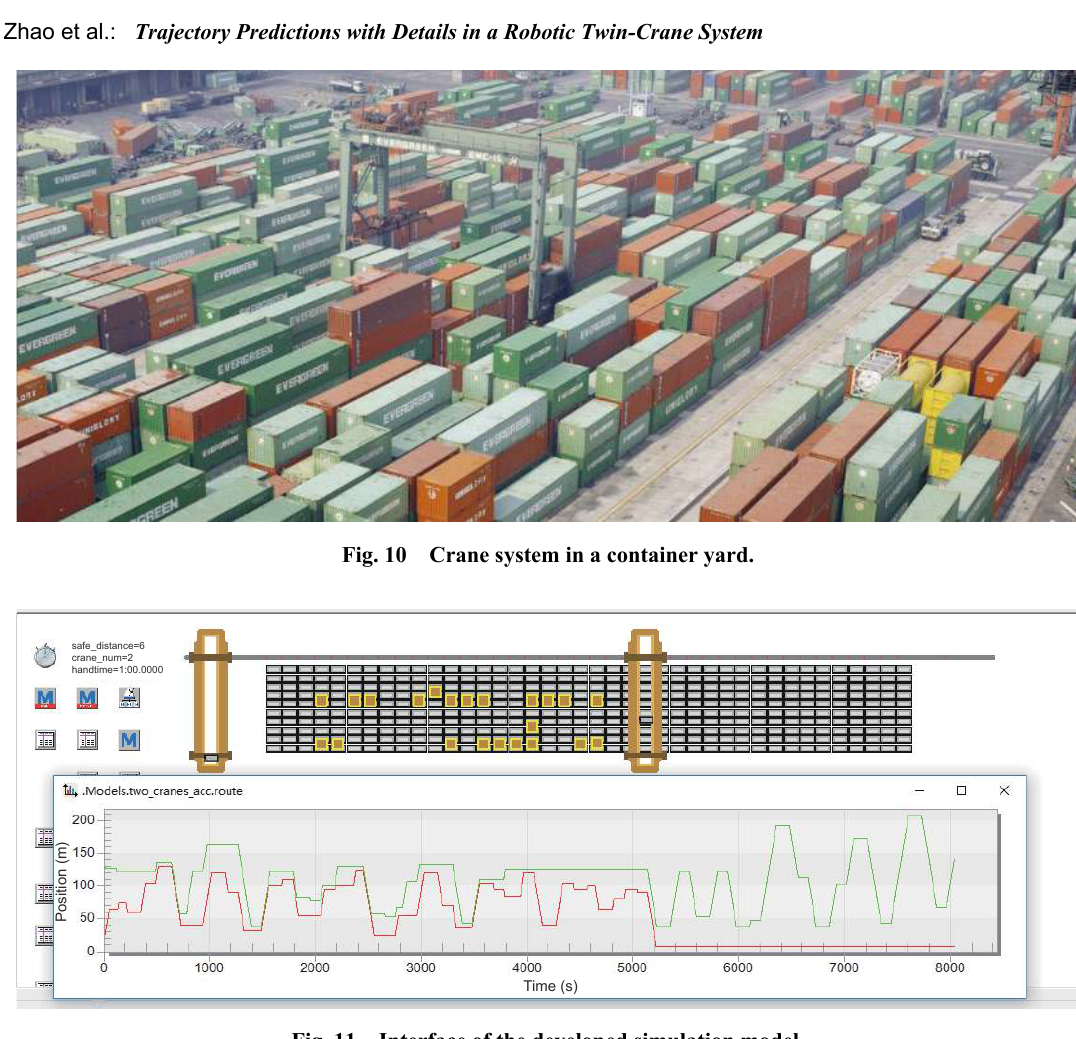
Fig. 11 Interface of the developed simulation